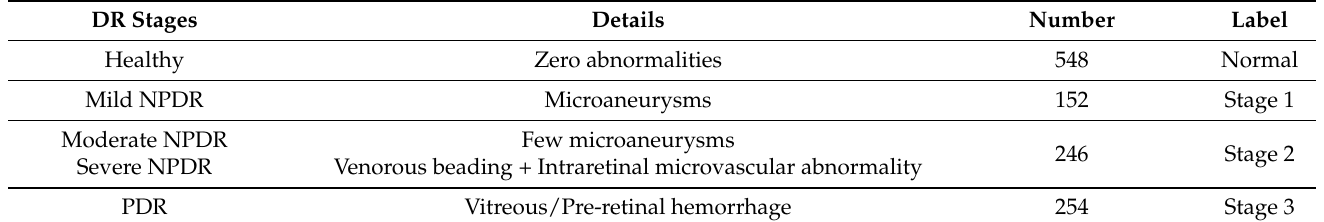
Table 1. Description of Messidor